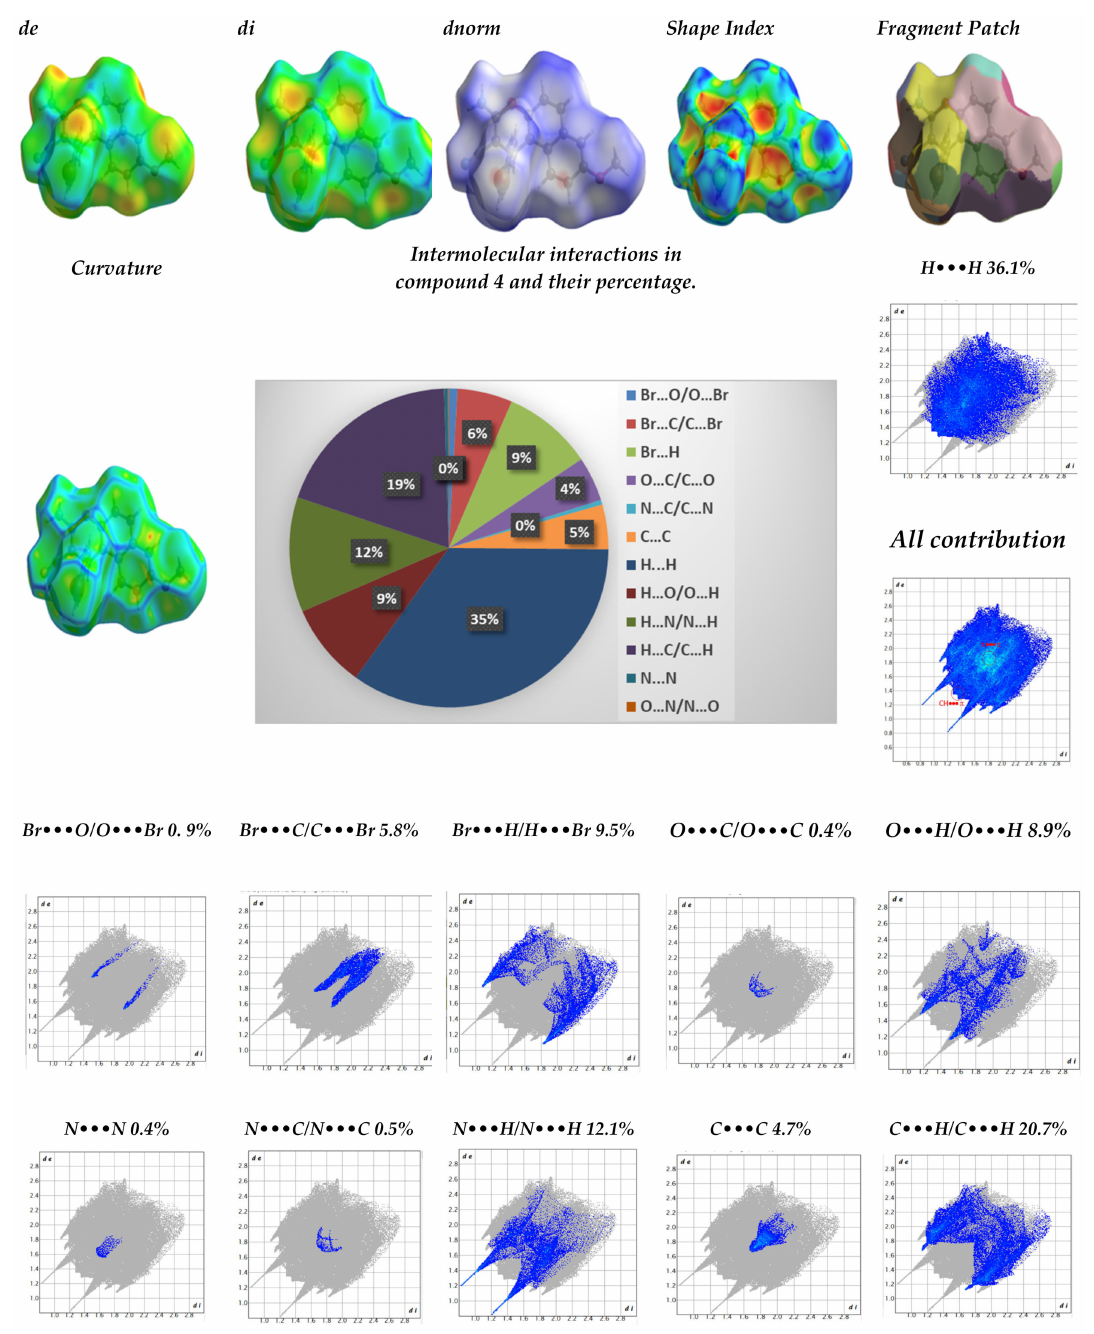
Figure 3. The “HF” Hirschfeld, 2D interaction diagrams, and its impact are shown by the dnorm ”normalized contact distance”, di ”distance to the nearest nucleus internal to the surface”, de ”distance from the point to the nearest nucleus external to the surface”, shape index “si”, and curvedness “crv” as well as fragment batch